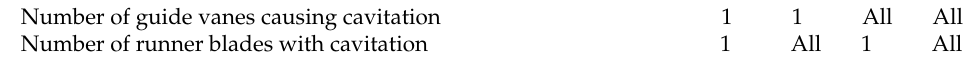
1 1 All All 1 All 1 All 1